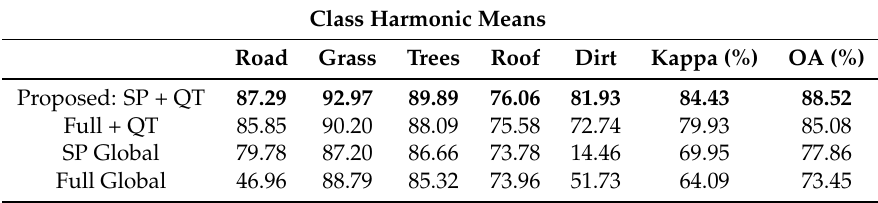
Table 8. Comparing harmonic means, Cohen’s kappa and overall agreement (OA) for the four methods. Class Harmonic Means Road Grass Trees